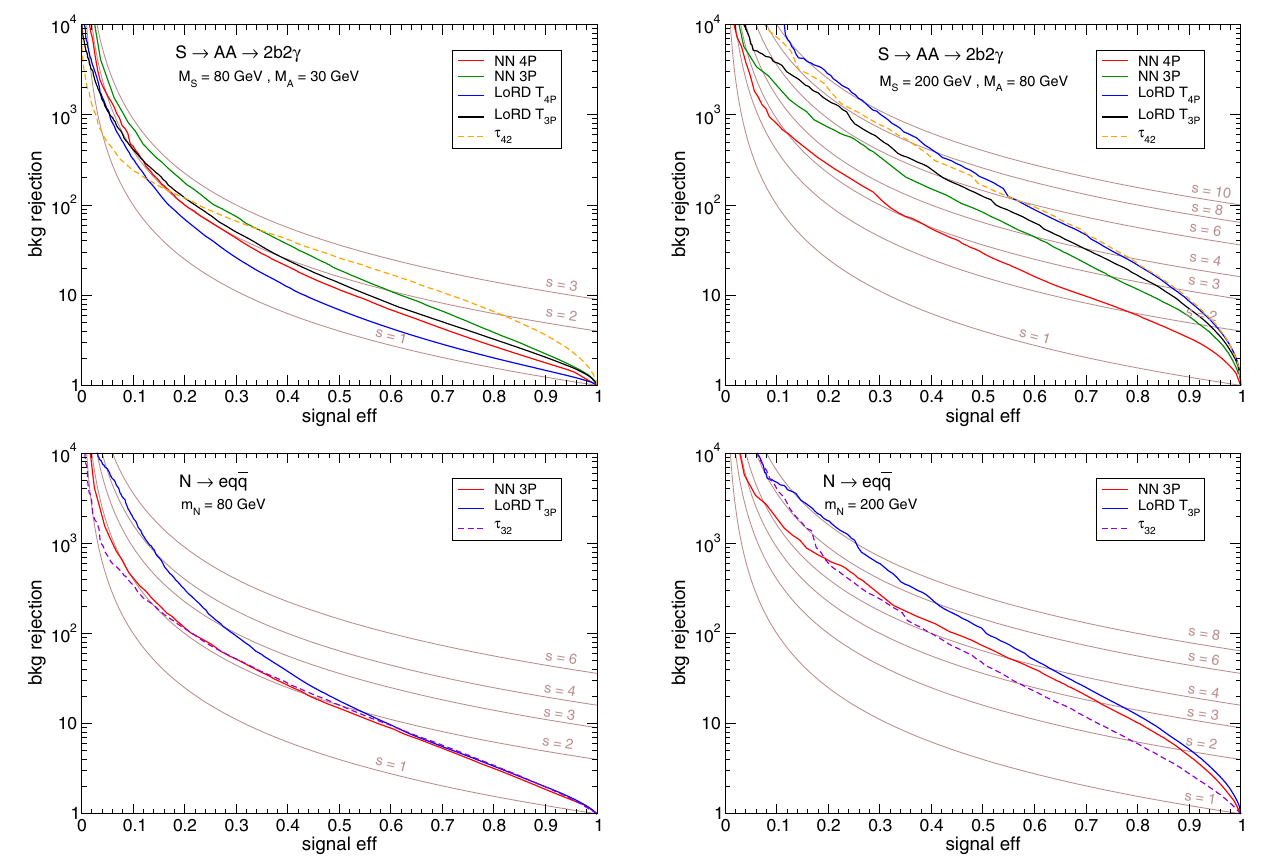
Fig. 4 ROC curves for the hi80 and hi200 taggers applied on selected signals giving multi-pronged jets containing electrons or photons, compared to τ -ratios and dedicated NNs (see the text)